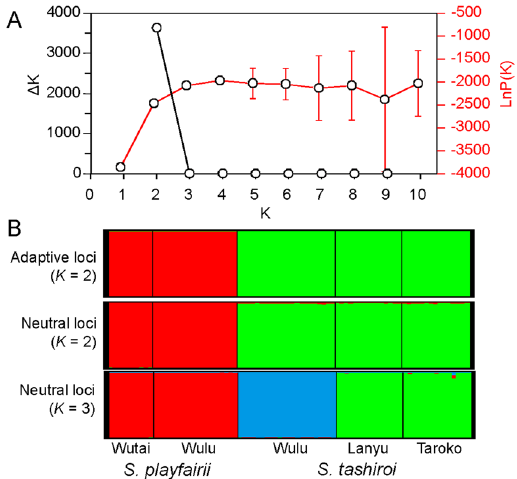
Figure 2. Results of Bayesian clustering analysis conducted by STRUCTURE. ( A ) The changes in Δ K and lnP( K ) in different clustering ( K ) situations in neutral loci. The Δ K plot shows that the highest Δ K value occurs at K = 2. This plot also shows lnP( K ), which demonstrates the increase in the posterior probability of K . ( B ) The clustering patterns of genetic components by two groups ( K = 2) in adaptive loci (positive outliers) and the patterns by two ( K = 2) and three groups ( K = 3) in neutral loci.